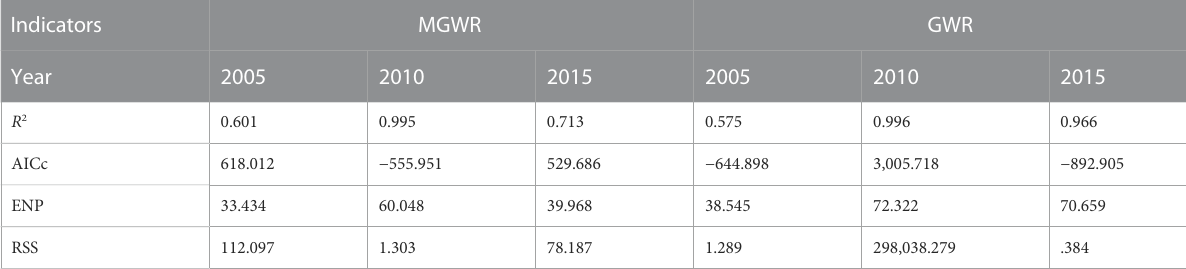
TABLE 3 Statistics of GWR and MGWR model indicators.